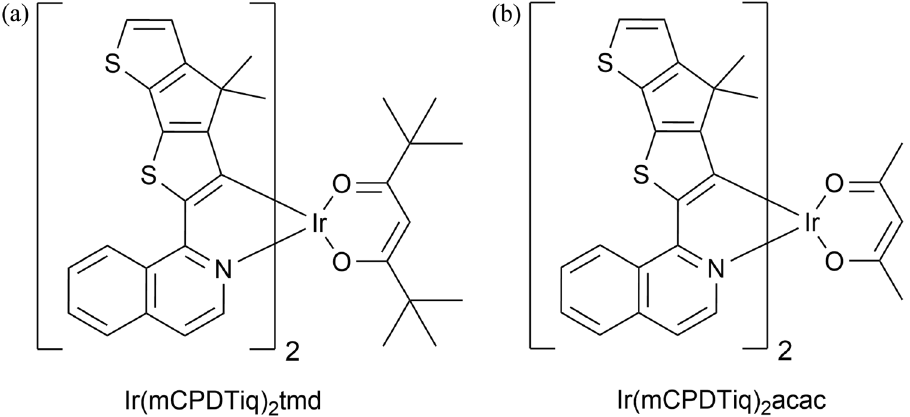
Figure 1. Chemical structures of ( a ) Ir(mCPDTiq) 2 tmd and ( b ) Ir(mCPDTiq) 2 acac.